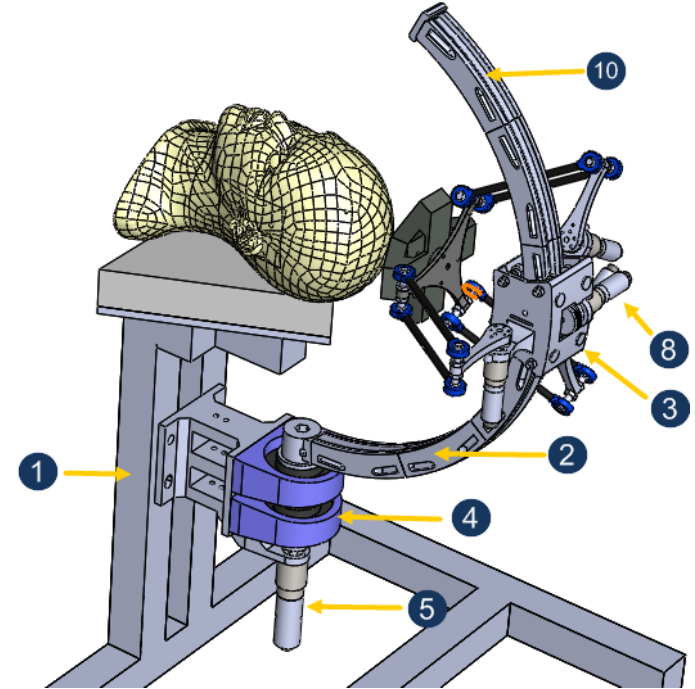
Figure 6. Mechanical design of the CochleRob manipulator.